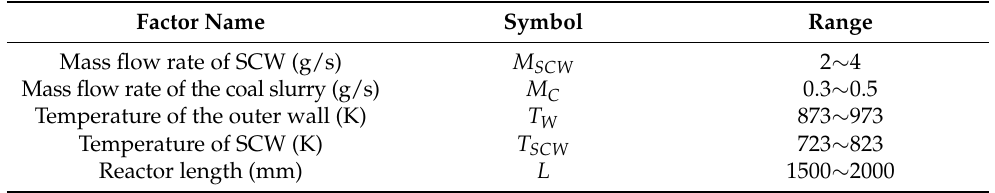
Table 4. The values of selected variables of the SCWFB reactor.